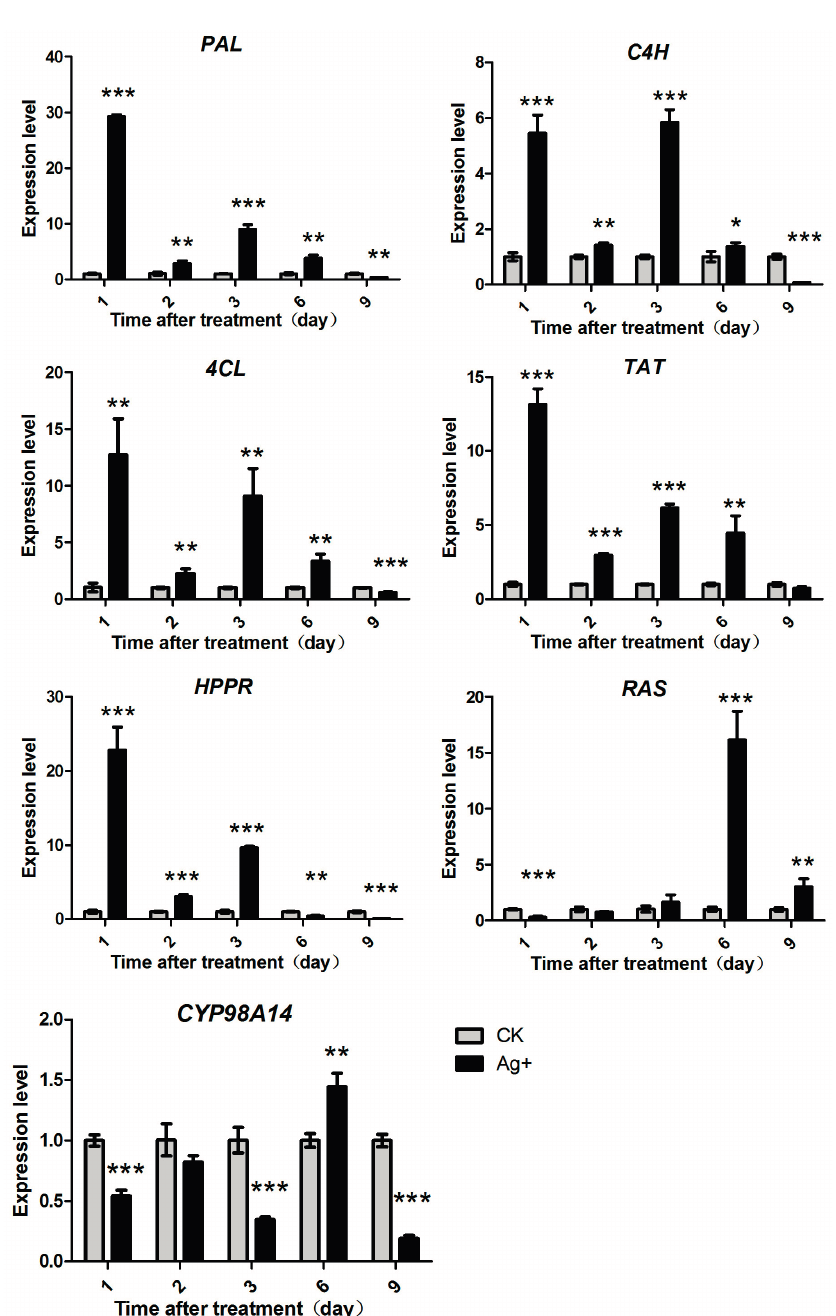
Figure 6. Effects of Ag + on the expression level of seven key enzyme genes of RA biosynthesis pathway (phenylpropanoid pathway and the tyrosine pathway) in S. miltiorrhiza hairy roots. The vertical bars show the SD values ( n = 3). The asterisks indicate statistically significant differences at p < 0.05 ( * , 0.01 < p < 0.05; ** , 0.001 < p < 0.01; *** , p < 0.001.) between the content in the elicitor treated cultures and that in the corresponding